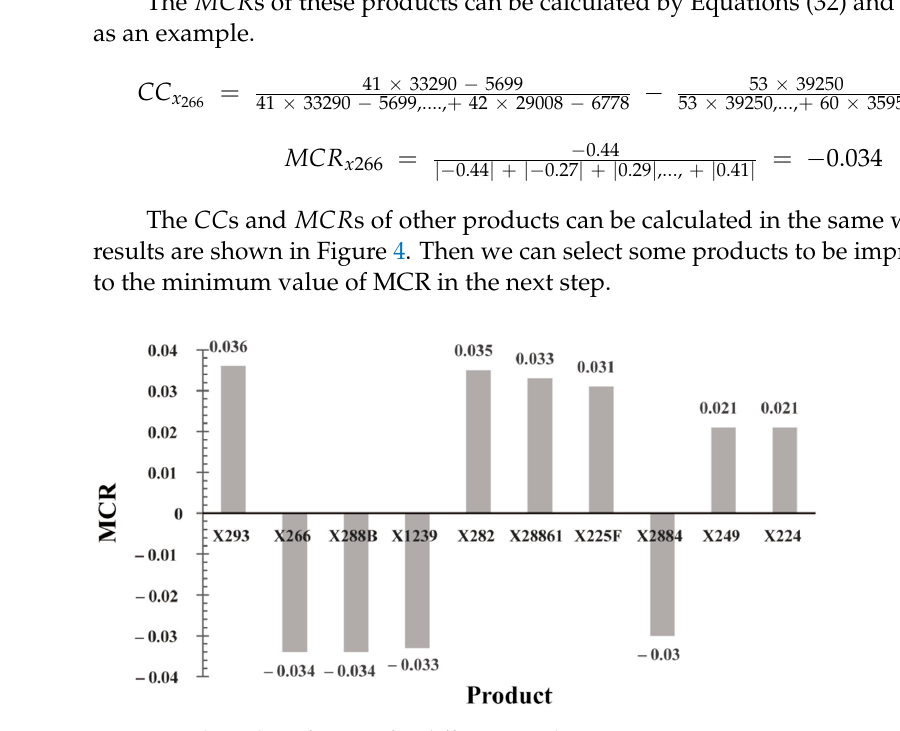
Figure 6. 4M1E analysis of 𝒙 𝟐𝟔𝟔 and improvement plans. 5.2.4. Checking the Improvements for All Selected Objectives Based on the idea of PDCA cycle, all the improvements for the selected objectives should be checked. To be specific, the process would move on next stage if the results of improvement reach the intended target. Otherwise, the process should return to Section 5.2.3. and make a new improvement plan for these selected objectives. 5.2.5. Restarting a Cycle In order to improve the manufacturing system continuously, the application frame- work of MPSE is a cyclical process. In addition, the multiproduct production system changes randomly with external and internal changes, such as the order changes, im- provement of equipment, and so on. Therefore, the losses of equipment in the system and